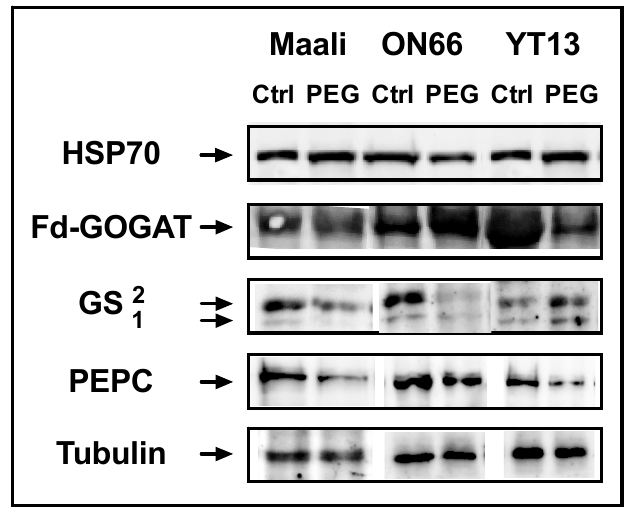
Figure 4. Immunoblotting using antisera for HSP-70, Fd-GOGAT, GS1 / GS2 and PEPC, under control (Ctrl) and osmotic stress conditions (PEG) for three durum wheat genotypes. In the last line, antisera for tubulin is shown to check equal